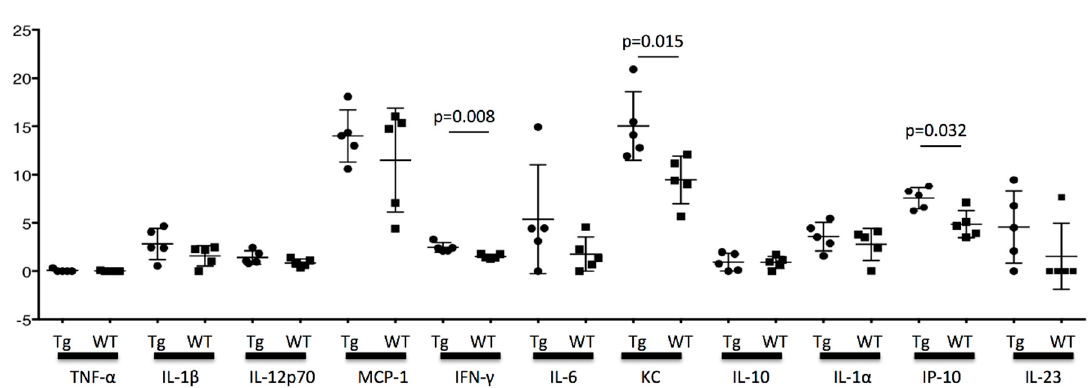
Figure 8. Cytokine concentration in the testis. Cytokine concentration in the testis was measured using FCM at the age of 16 weeks. The significant di ff erence between KCASP1Tg and wild-type mice was detected for INF- γ , KC (a mouse neutrophil chemoattractant protein), and IP-10 (CXCL10 chemokine, produced from monocyte, endothelial cell, and fibroblast when treated with IFN- γ ) ( p = 0.008, p = 0.015, and p = 0.032, respectively). TNF- α was undetected. No significance was detected for other